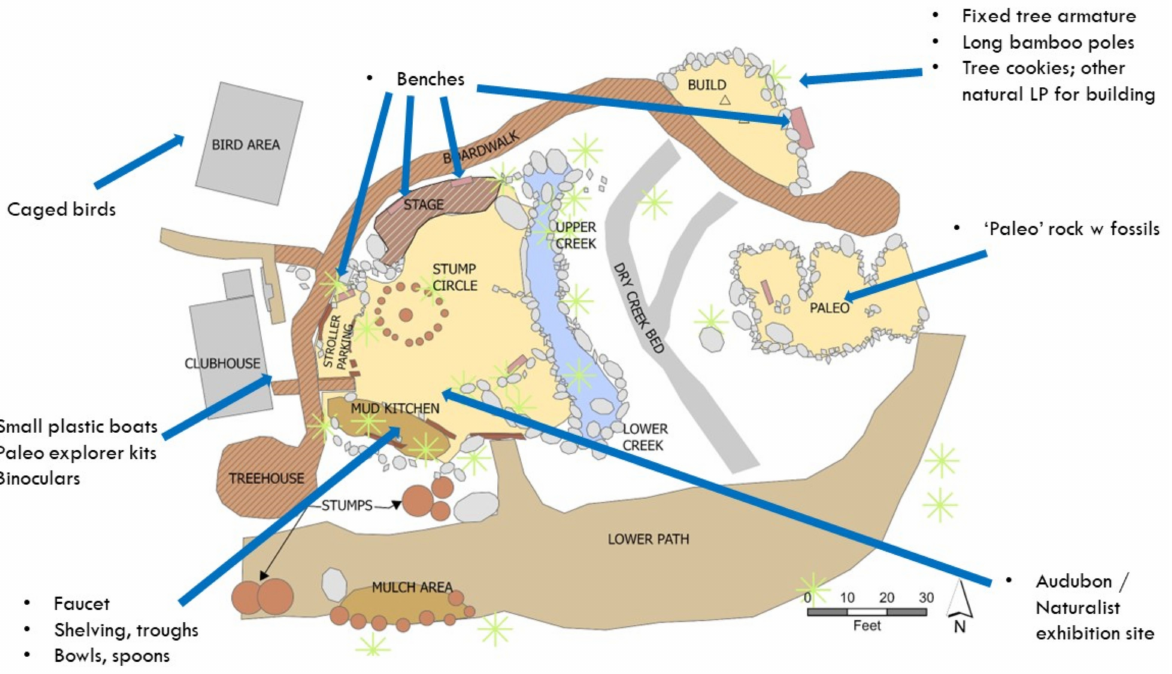
Figure 1. Fixed features and loose parts in The Backyard .